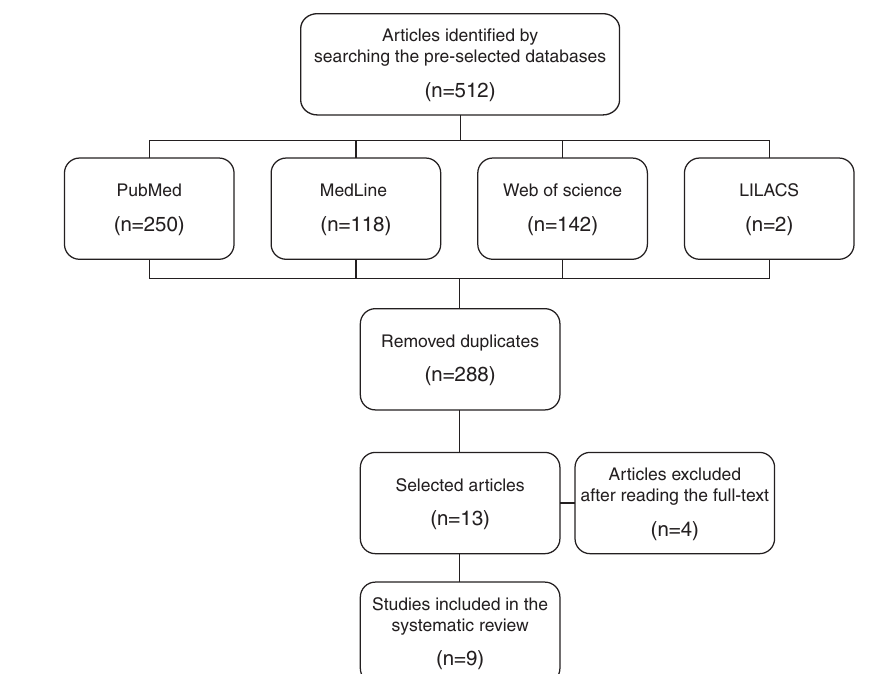
Figure 1 Flowchart of the search and selection process of studies on auditory thresholds in pediatric patients with cystic fibrosis treated with ototoxic